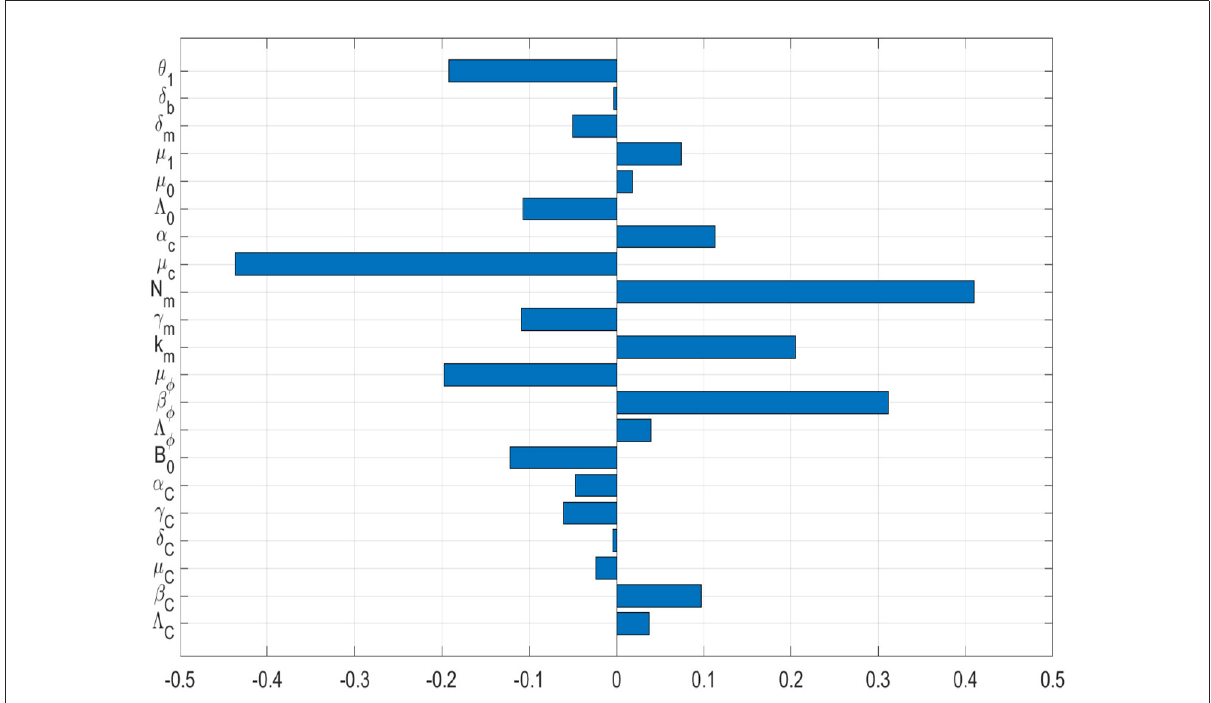
FIGURE6 Tornado plot of partial rank correlation coefficients (PRCCs) of the model parameters that influence the PTB transmission metric R 0